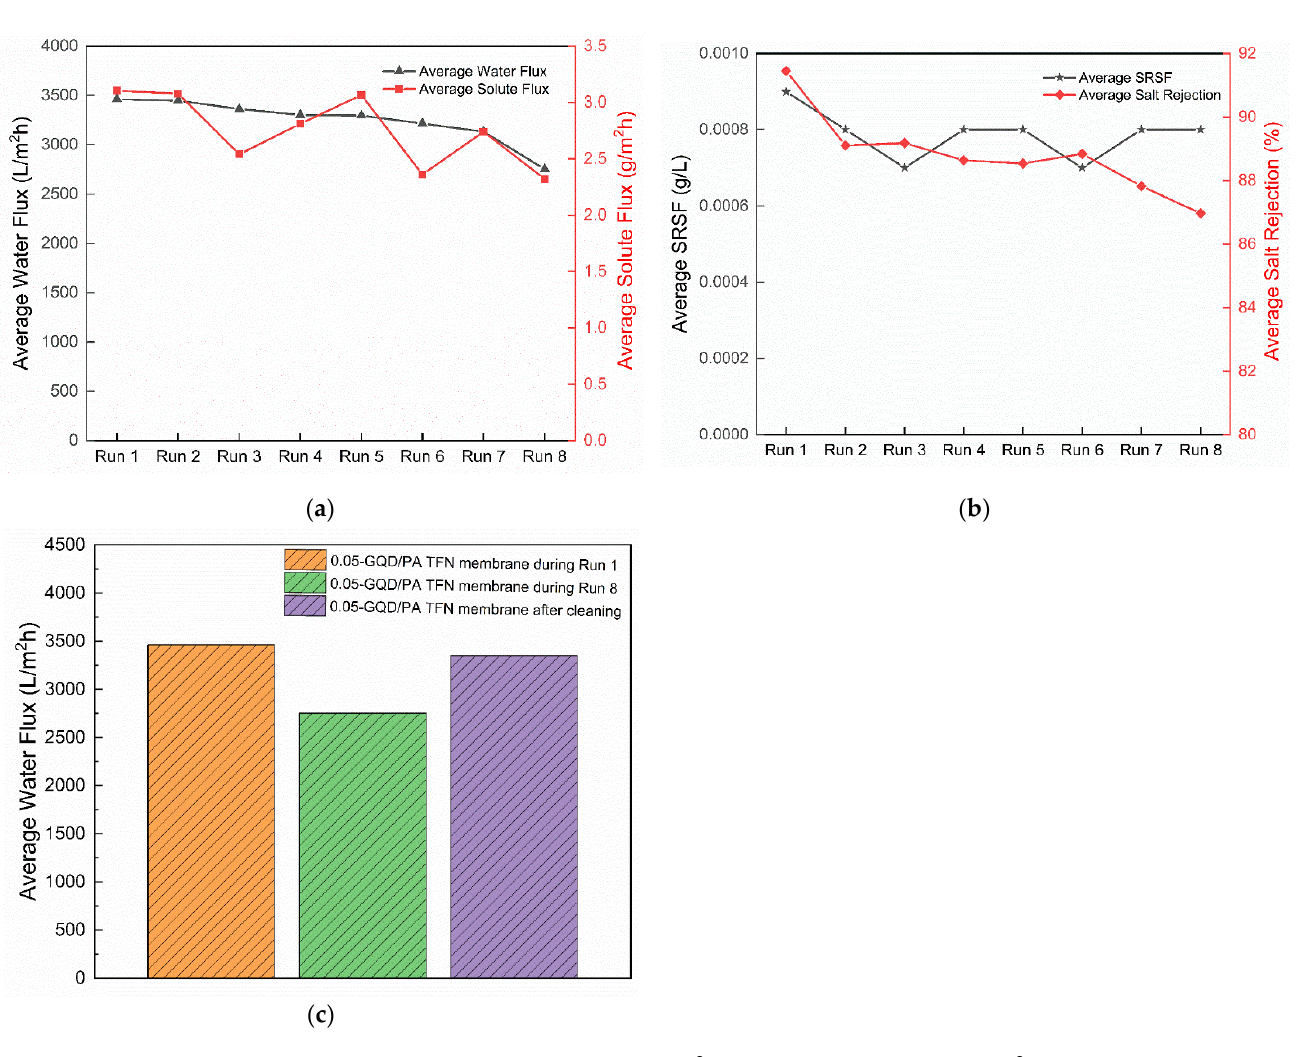
Figure 13. ( a ) Average water flux (L/m 2 h) and average solute flux (g/m 2 h) of the 0.05-GQD/PA TFN membrane during long-term performance analysis—8 runs ( b ) Average SRSF (g/L) and Average salt rejection (%) of the 0.05-GQD/PA TFN membranes during long-term performance analysis—8 runs ( c ) Cleaning efficiency after long term FO Testing with 0.05-GQD/PA TFN membrane.